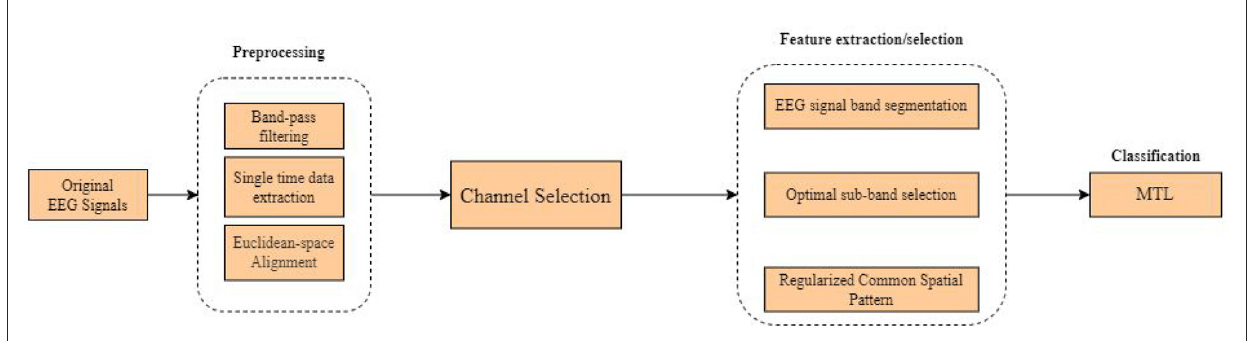
FIGURE3 The processing flow of the proposed